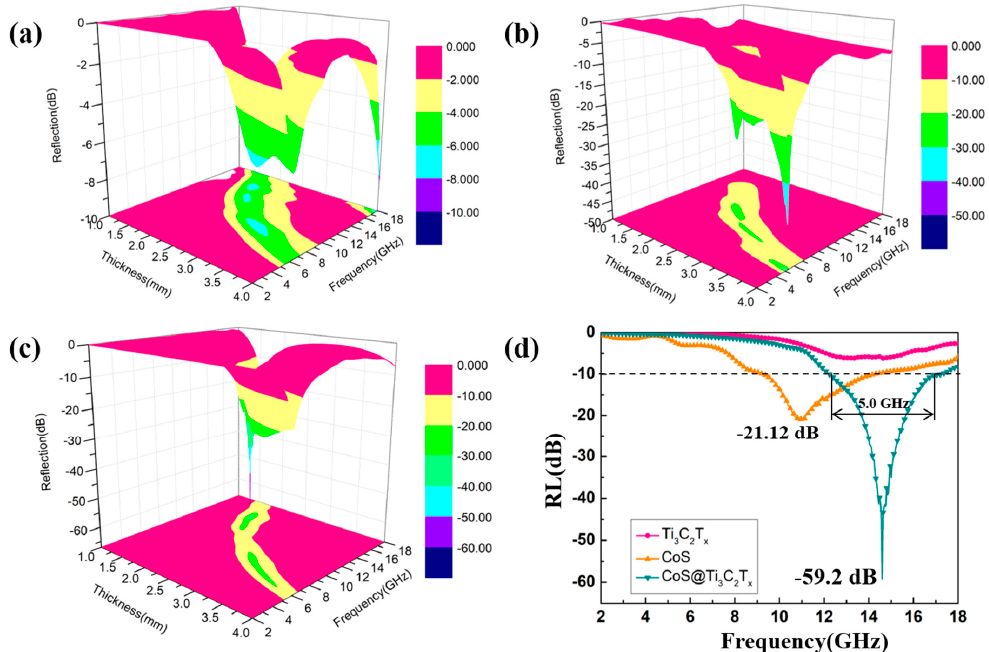
Figure 11. Three dimensional profiles of RL values of Ti 3 C 2 T x (40 wt %) ( a ), CoS (40 wt %) ( b ), CoS@Ti 3 C 2 T x (40 wt %) ( c ), and the RL curves at the thickness of 2.0 mm for them ( d ).